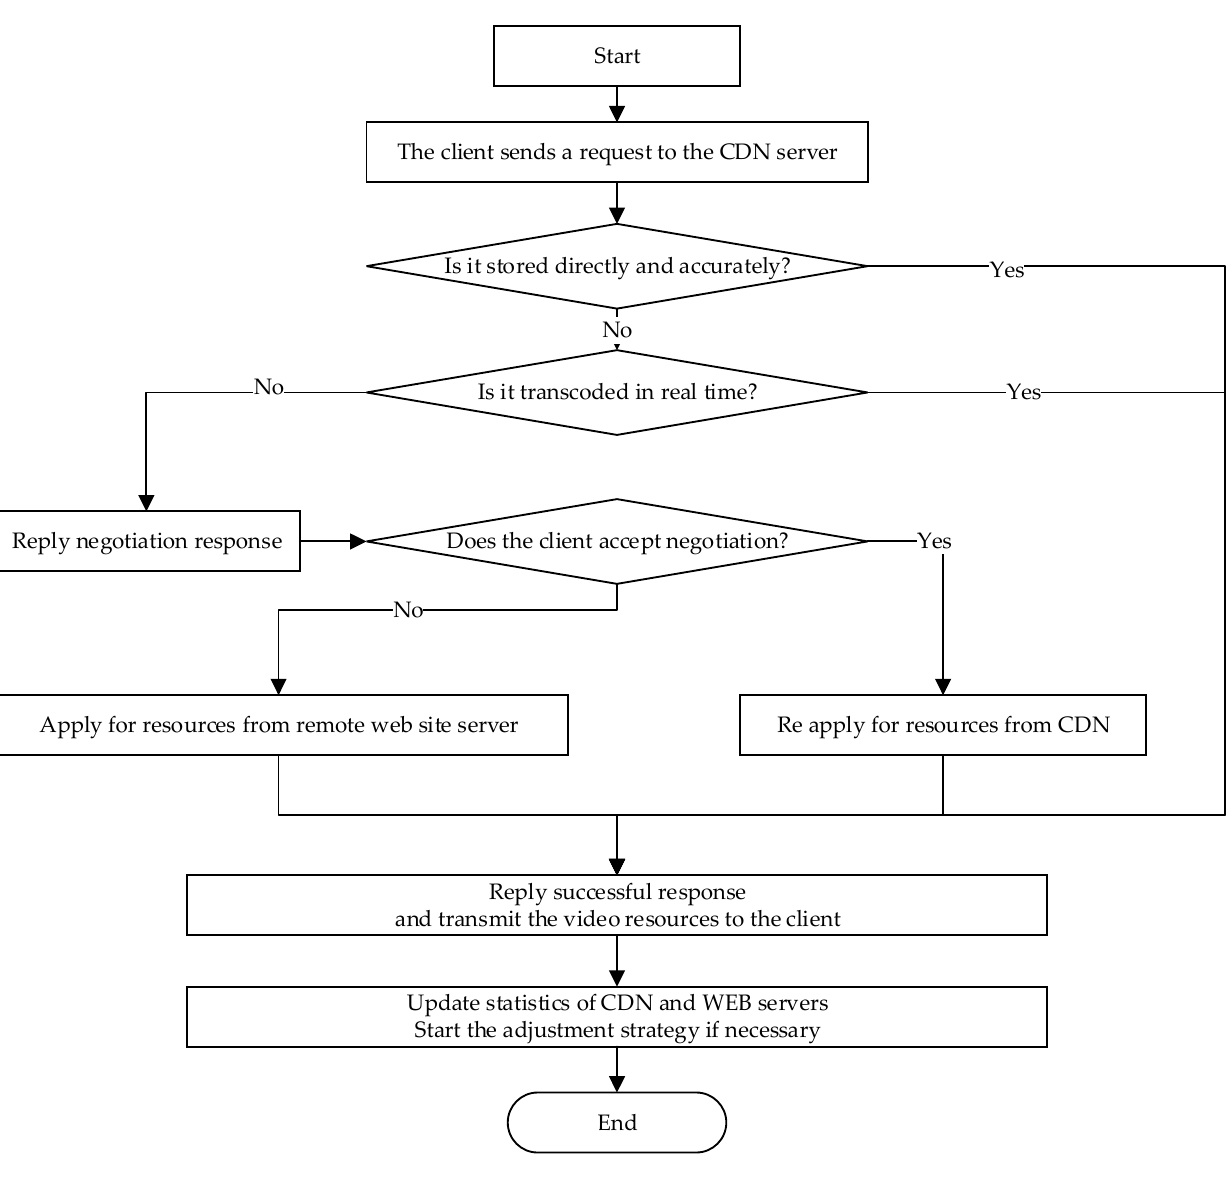
Figure 3. Sequence diagrams of CDN direct storage of video format.